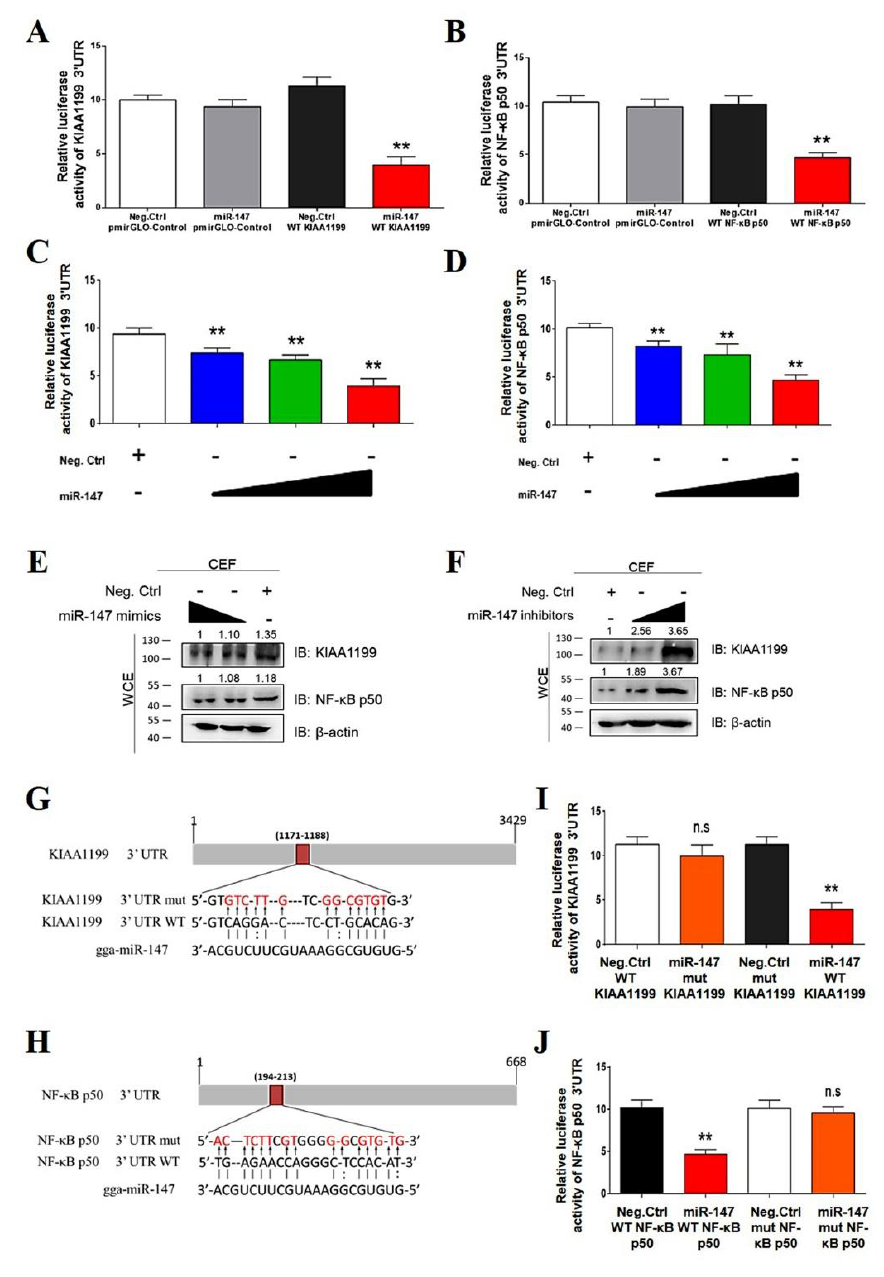
Figure 5. MiR-147 regulated NF- κB p50 and KIAA1199 by targeting the 3′ UTR. ( A ) miR-147 inhibited reporter activities of the pmirGLO- KIAA1199 3′ UTR. miR-147 mimics (40 nM) or negative controls were co-transfected with pmirGLO-Control or pmirGLO- KIAA1199 3′ UTR reporter plasmid into 293T cells. ( B ) miR-147 inhibited reporter activities of pmirGLO-NF- κB p50 3′ UTR. miR -147 mimics (40 nM) or negative controls with pmirGLO-Control or pmirGLO-NF- κB p50 3′ UTR re- porter plasmid were co-transfected into 293T cells. ( C ) miR-147 mimics (10, 20, and 40 nM) or a negative control were co-transfected along with pmir-GL0- KIAA1199 3′ UTR reporter plasmid into 293T cells. ( D ) miR-147 mimics (10, 20, and 40 nM) or a negative control were co-transfected along with pmir-GL0- NF- κB p50 3′ UTR reporter plasmid into 293T cells. ( E ) miR-147 inhibited the ex- pressions of KIAA1199 and NF- κB p50 in a dose -dependent manner. miR-147 mimics (20 and 40 nM) were transfected into ALV-J and REV co-infected CEF cells, after which WB was performed with anti-KIAA1199 antibody or anti- NF- κB p50 antibodies 48 h post -transfection. ( F ) Inhibition of miR-147 promoted the expression levels of KIAA1199 and NF- κB p50. miR -147 inhibitors (30 and 60 nM) were transfected into CEF cells, after which WB was performed with anti-KIAA1199 or anti- NF- κB p50 antibodies 48 h post -transfection. ( G ) Schematic of predicted seed sequence of miR-147 which binds with KIAA1199 3’ UTR. ( H ) Schematic of predicted seed sequence of miR-147 which